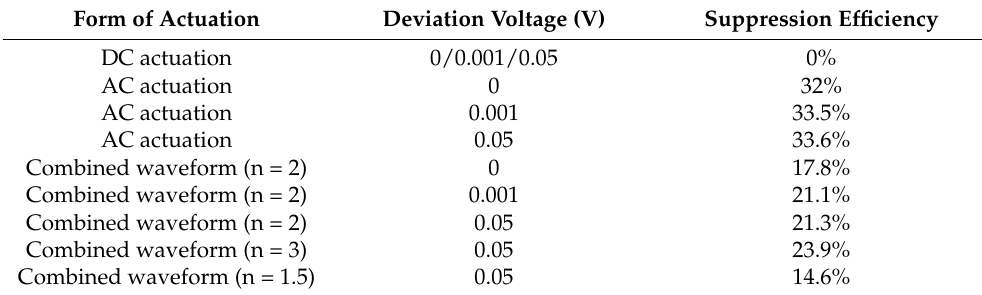
Table 2. Suppression efficiency under different forms of